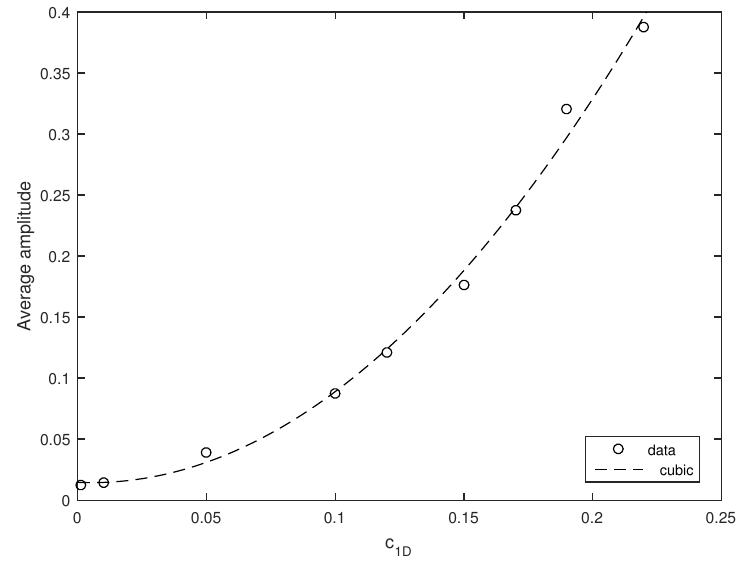
Figure 11. Average amplitude of the oscillations of the zooplankton density obtained for different values of c 1 D ; other parameters are the same as in Figure 10. The black dashed line shows the best-fit of the data by a cubic polynomial, y = − 0.12 x 3 + 8.3 x 2 − 0.0087 x +